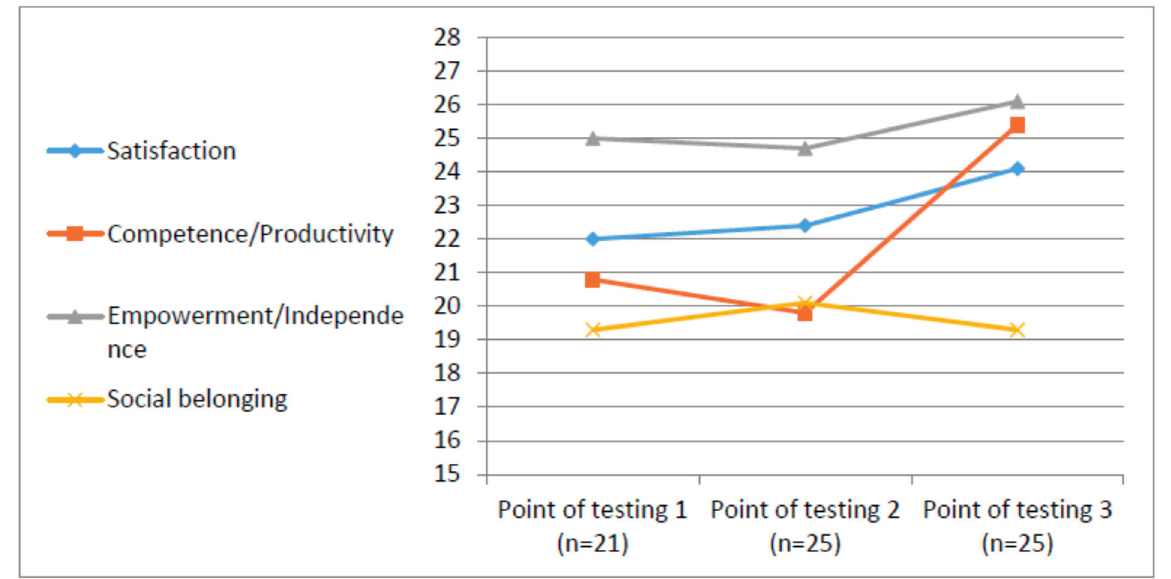
Figure 2. Comparison of personal perception of quality of life by QOL-Q at three different points of testing Point of Testing 1—at the beginning of the course; Point of Testing 2— at the end of the course; and Point of Testing 3—after six month of integration in army